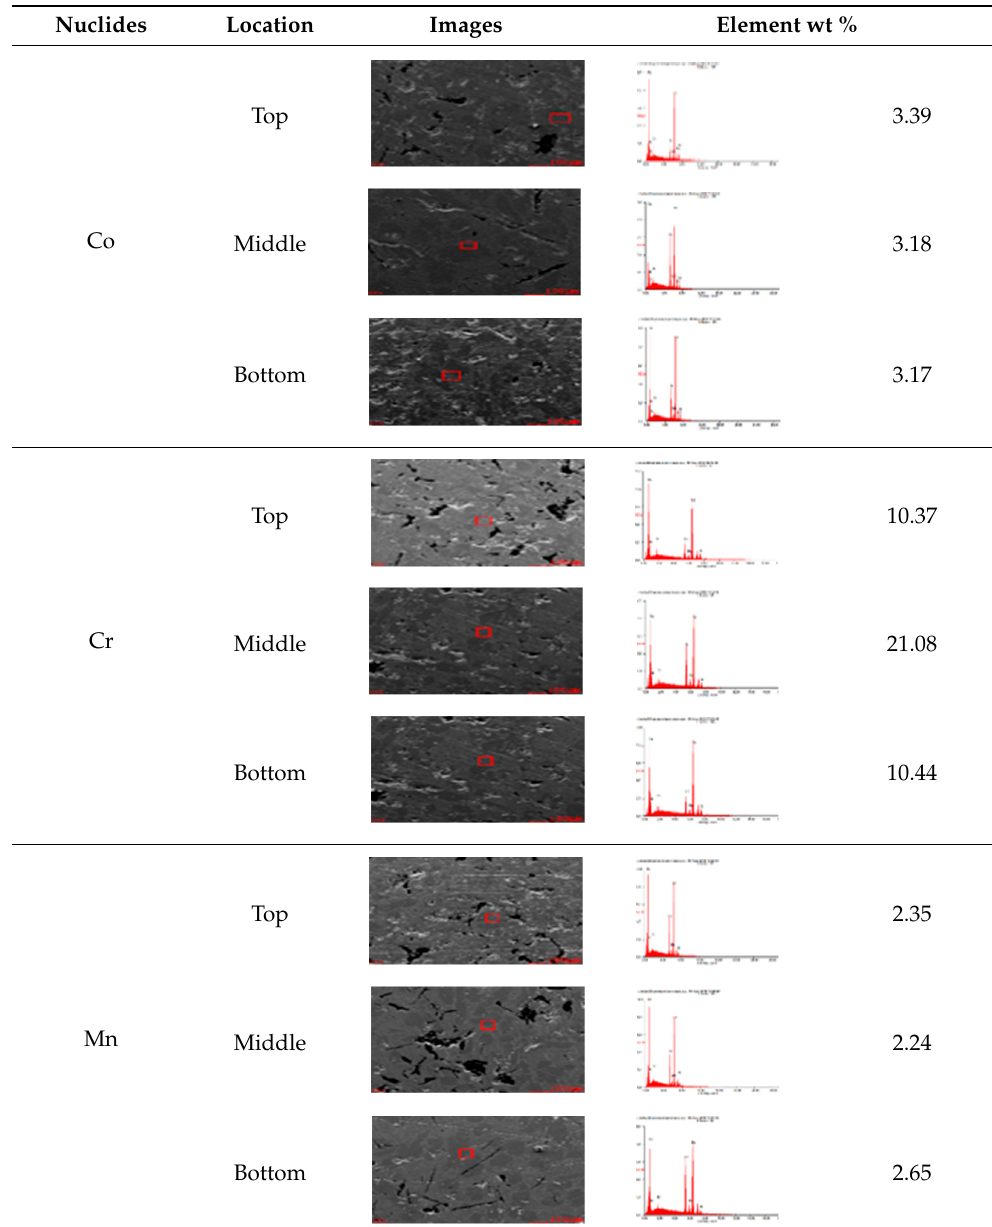
Table 10. Analysis results of distribution.